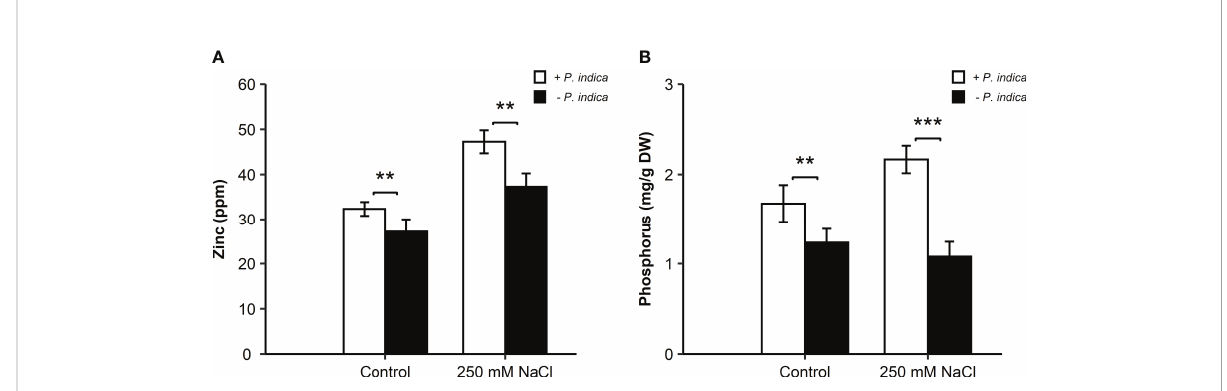
FIGURE 5 Zinc and phosphorus concentration in P. indica inoculated and non-inoculated date palm seedling roots under control and salt stress conditions. (A) Root zinc concentration (ppm) for P. indica colonized and non-colonized date palm seedlings. (B) Root phosphorus concentration (mg/g DW) of P. indica inoculated and non-inoculated date palm seedlings. The values are the means ± SD (n = 3), analyzed by Student ’ s t- test, **p < 0.01 and ***p <